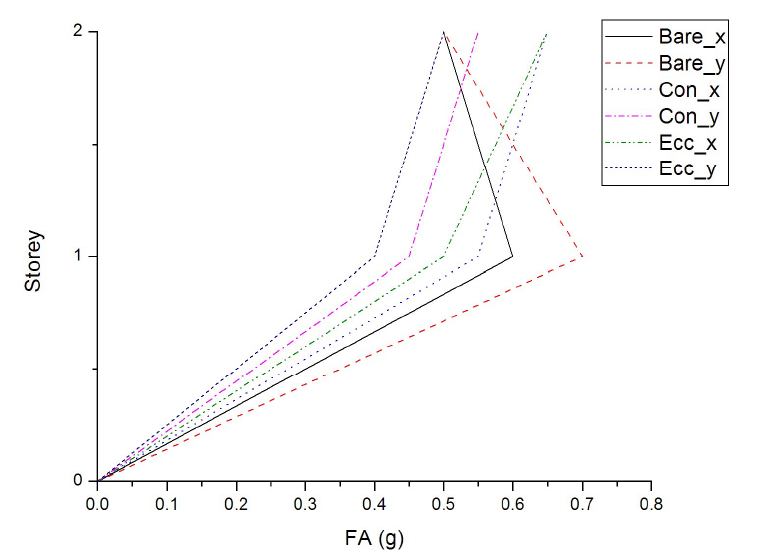
Figure 6. Distribution of peak FA for the RC building with and without the seesaw system, subjected to seismic motion No. 4 of Table 3.